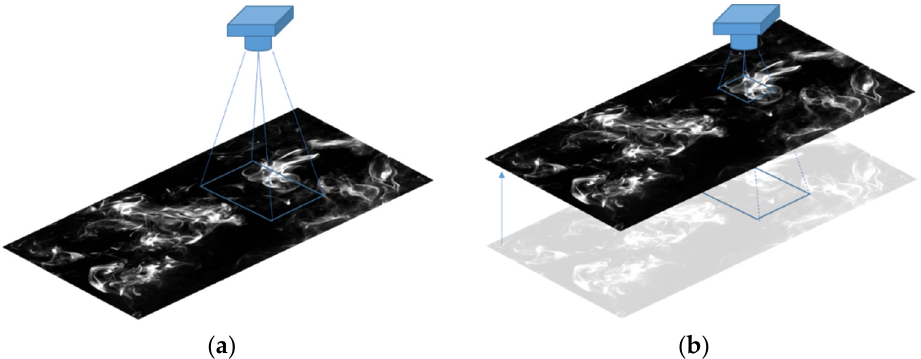
Figure 7. Camera distance from the measurement plane: ( a ) the original distance of image acquisition for training of the learner; ( b ) the incorrect camera distance, which results in a wrongly zoomed-up image to be input by the learner.